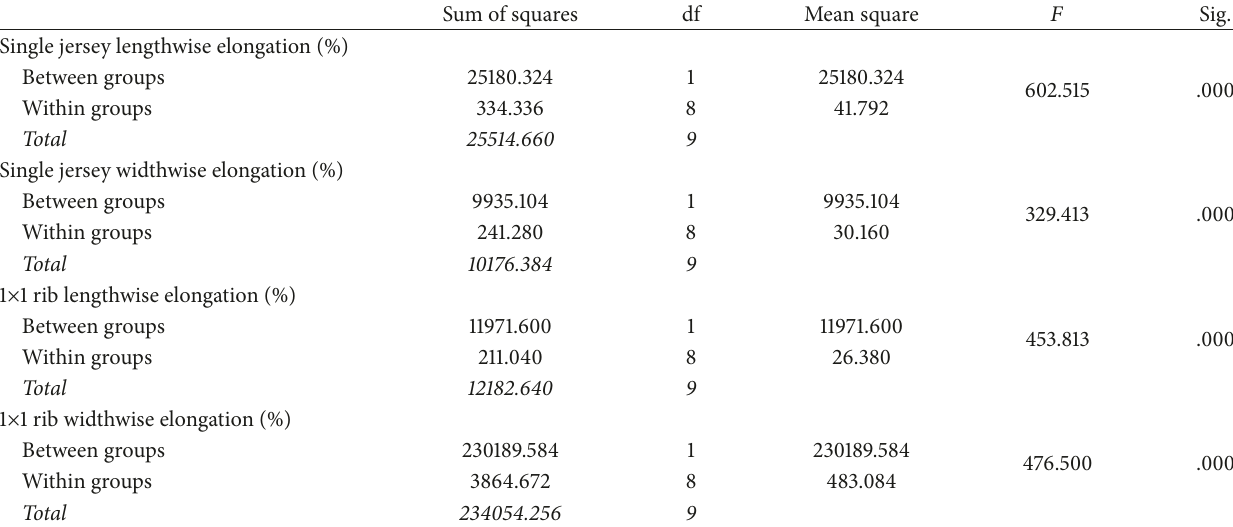
Table 10: Analysis of variance for elongation (%) of single jersey and 1 × 1 rib knitted fabrics made from 100% cotton and cotton/Lycra (95/5%). Sum of squares df Mean square 𝐹 Sig.